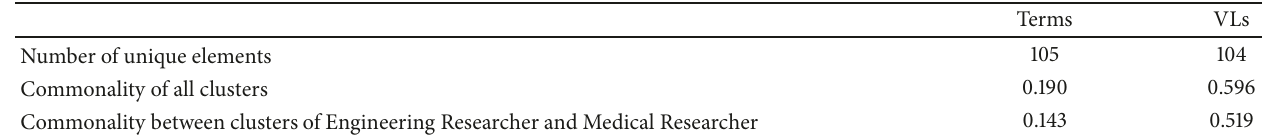
Table 7: Commonalities of terms and VLs.